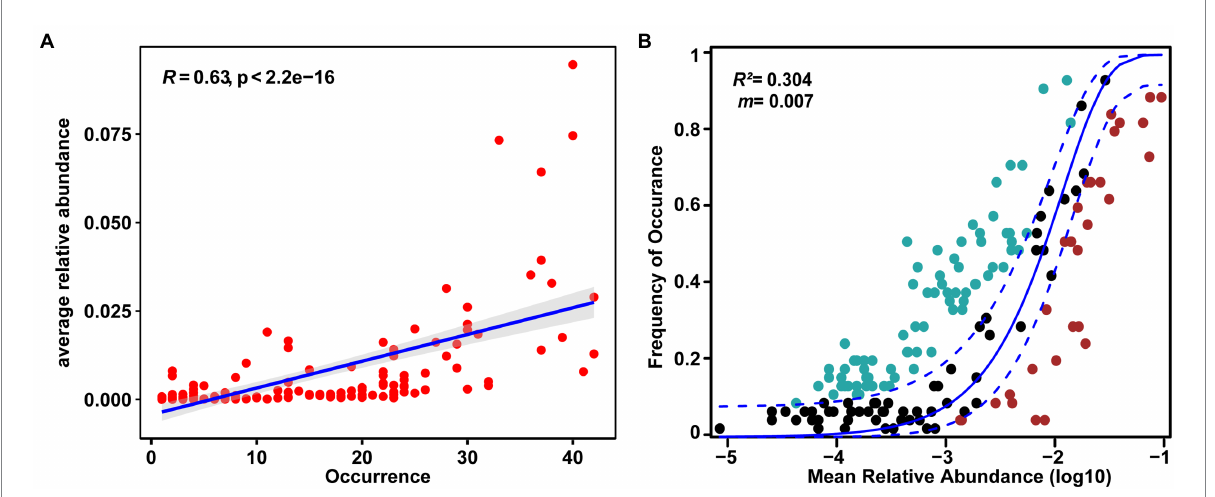
FIGURE 5 Relationships between occurrence and abundance of ectomycorrhizal (EM) fungal OTUs. (A) Abundance–occupancy relationship based on all OTUs. Spearman’s rank correlation was calculated between average relative abundance and the number of sites occurred; (B) The neutral community model (NCM) of community assembly for EM fungal community.